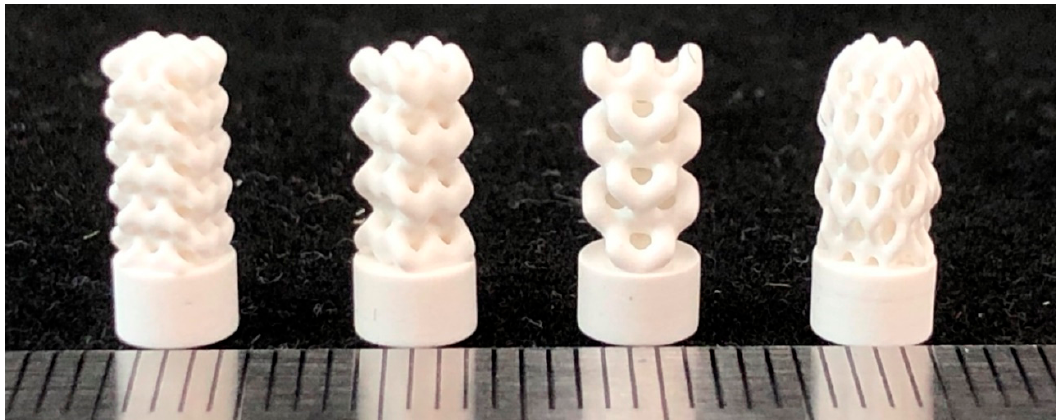
Figure 8. Photographs of printed implants fabricated from models developed earlier and shown in Figure 5.